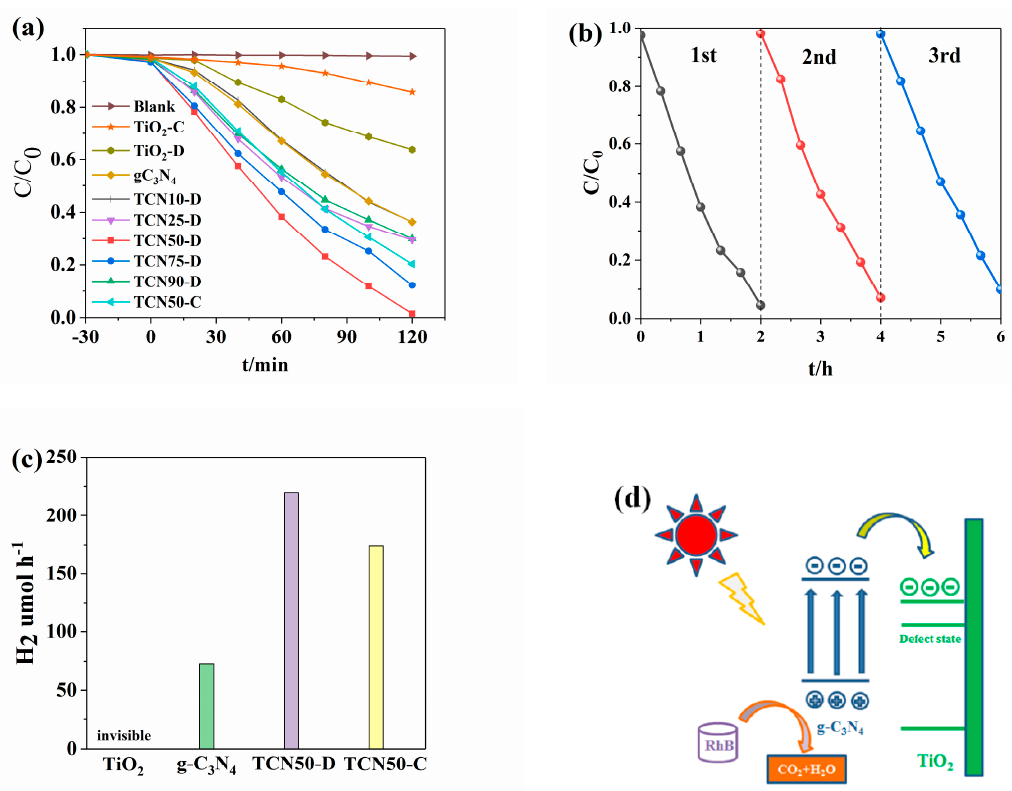
Figure 6. ( a ) Photocatalytic degradation of RhB under visible light irradiation. ( b ) The photodegradation stability of RhB over TCN50-D sample. ( c ) Photocatalytic H 2 evolution rates of TiO 2 , g-C 3 N 4 , TCN50-C and TCN50-D under visible light irradiation. ( d ) Photocatalytic mechanism for the charge transfer between g-C 3 N 4 and TiO 2 under visible light irradiation.